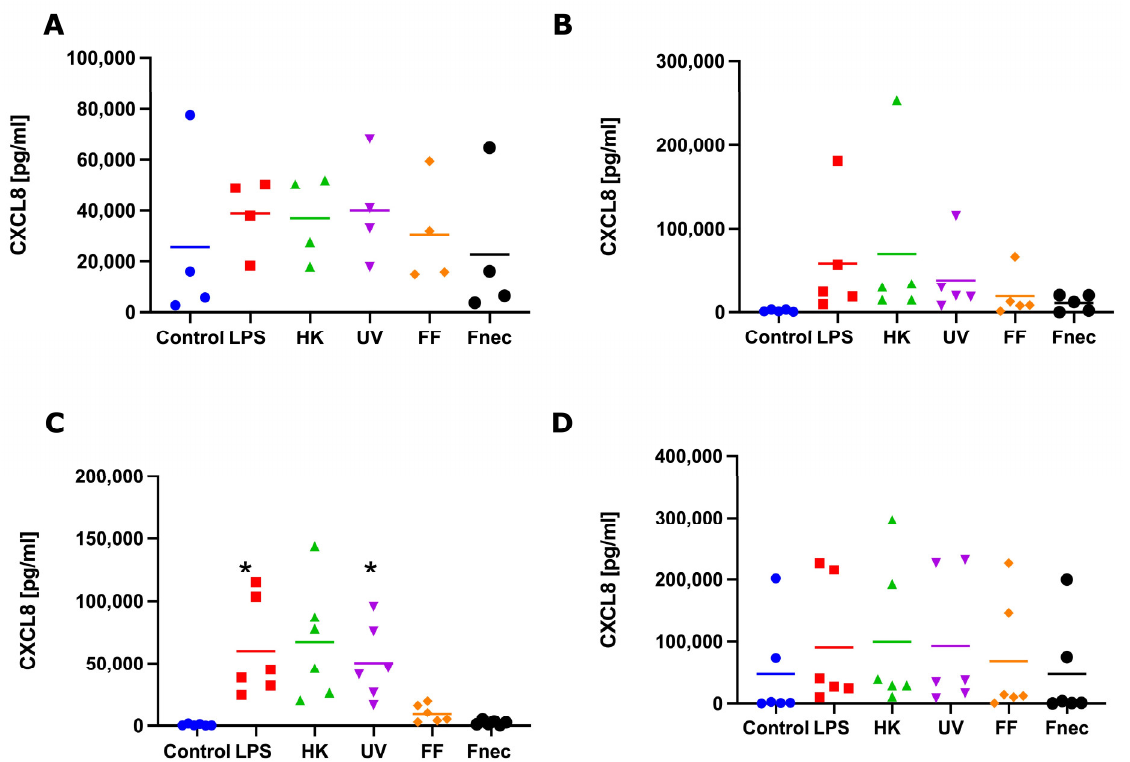
Figure 5. CXCL8 protein released into cell culture medium by interdigital ovine keratinocytes and fibroblasts. Primary keratinocytes free of M. fermentans ( n = 4, ( A )) or naturally infected with M. fermentans ( n = 5, ( B )) and primary fibroblasts free of M. fermentans ( n = 6, ( C )) or naturally infected with M. fermentans ( n = 6, ( D )) were stimulated with 1 µ g/mL E. coli LPS, heat-inactivated D. nodosus (HK), UV-inactivated D. nodosus (UV), formalin-fixed D. nodosus (FF) or heat-inactivated F. necrophorum (Fnec) for 24 h (cell culture medium was used as diluent and control). Horizontal line indicates the mean. Each replicated symbol represents a different cell line from an individual sheep. One- way-ANOVA, followed by Dunnett’s multiple comparisons test: * p < 0.05.